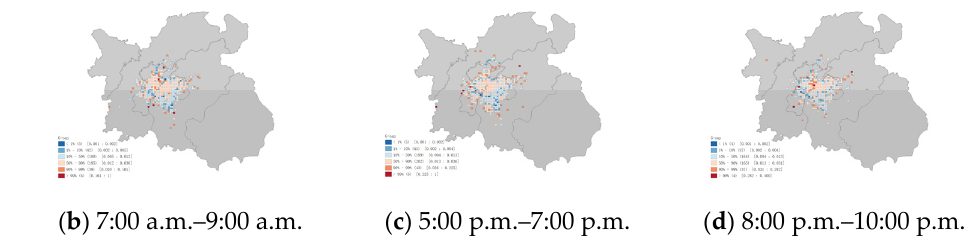
Figure 11. ( a ) Grid order acquisition probability (G-oap) of each grid area at 1:00 a.m.–3:00 a.m. ( b ) Grid order acquisition probability (G-oap) of each grid area at 7:00 a.m.–9:00 a.m. ( c ) Grid order acquisition probability (G-oap) of each grid area at 5:00 p.m.–7:00 p.m. ( d ) Grid order acquisition probability (G-oap) of each grid area at 8:00 p.m.–10:00 p.m.